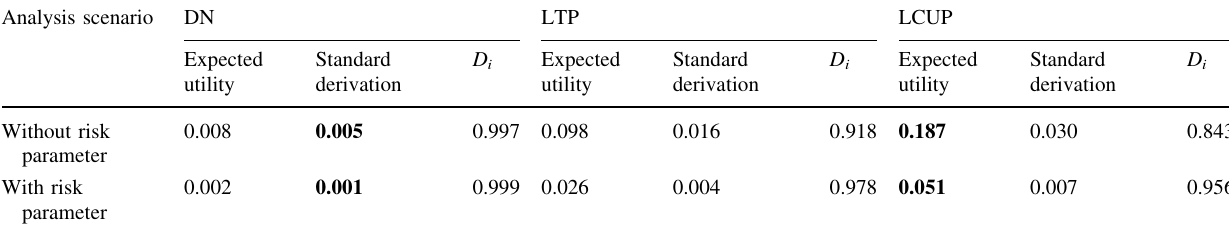
Table 6 Expected utility index and standard derivation of alternatives Analysis scenario